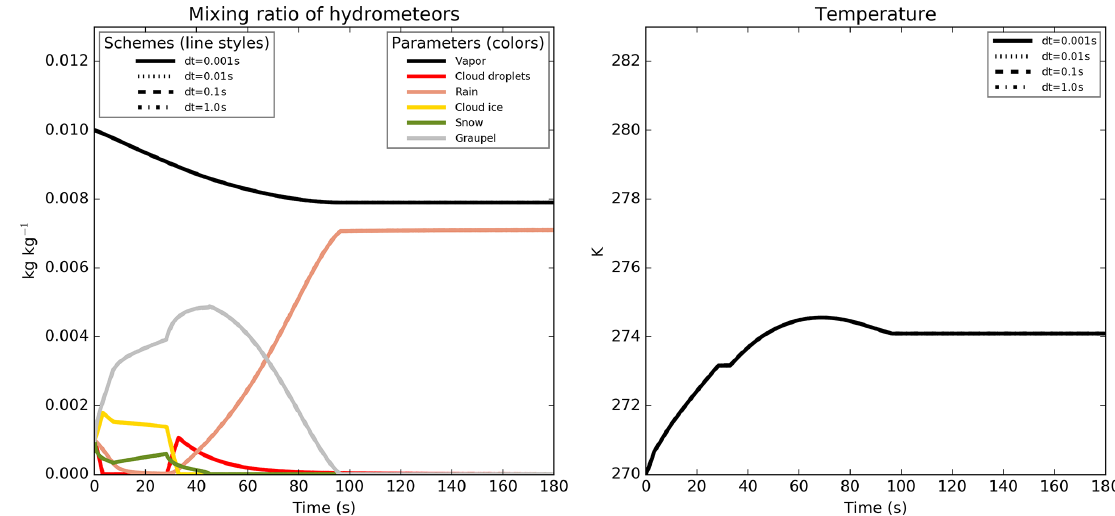
Figure 9. Same as Fig. 7 but using the new version of the microphysical scheme (all four curves are superimposed).